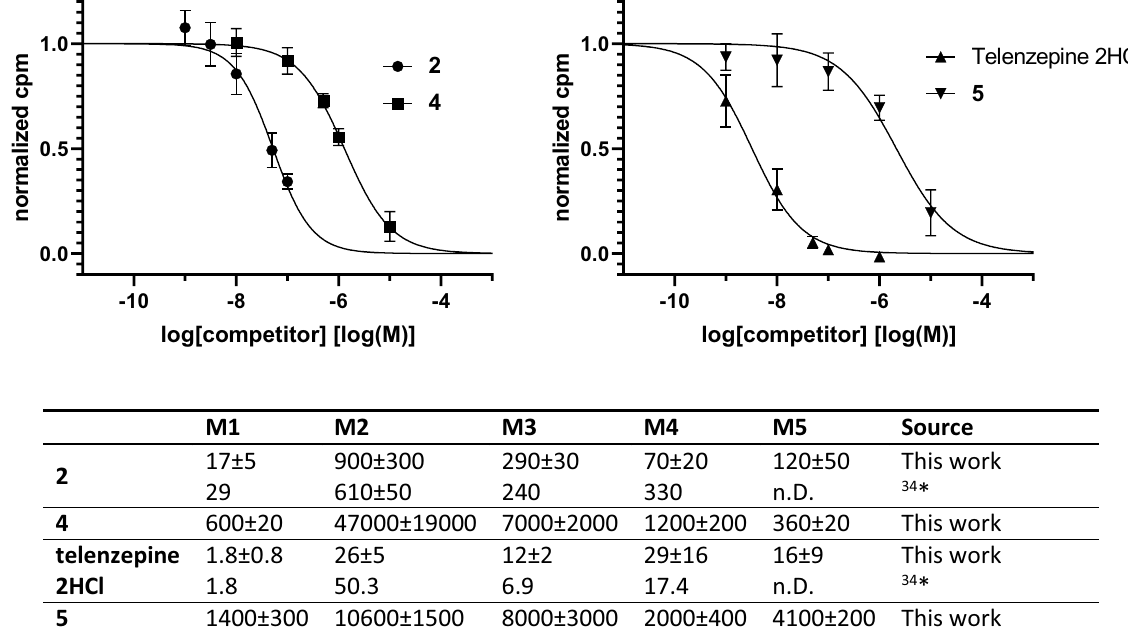
Figure 6. Competition binding curves using 0.2 nM [ 3 H]NMS on mAChR M1 membranes for compounds 2 , 4 , 5 and telenzepine dihydrochloride. Filter bound decay rate is normalized to 1 for binding in absence of competitor and to 0 for nonspecific binding. Error bars indicate the standard deviation of n = 3 measurements. The table shows K i -values (nM) as determined by a competitive radioligand binding assay using [N-methyl- 3 H]scopolamine methyl chloride ([ 3 H]NMS) on CHO cell membranes containing human mAChR receptors. All obtained binding displacement curves showed the expected sigmoidal shape. * Binding was carried out for 90 min at 37 °C, using membranes from rat heart tissue (M2) and transfected A9Lcells (M1 and M3) and in NG108-15 cells (M4) 34 .